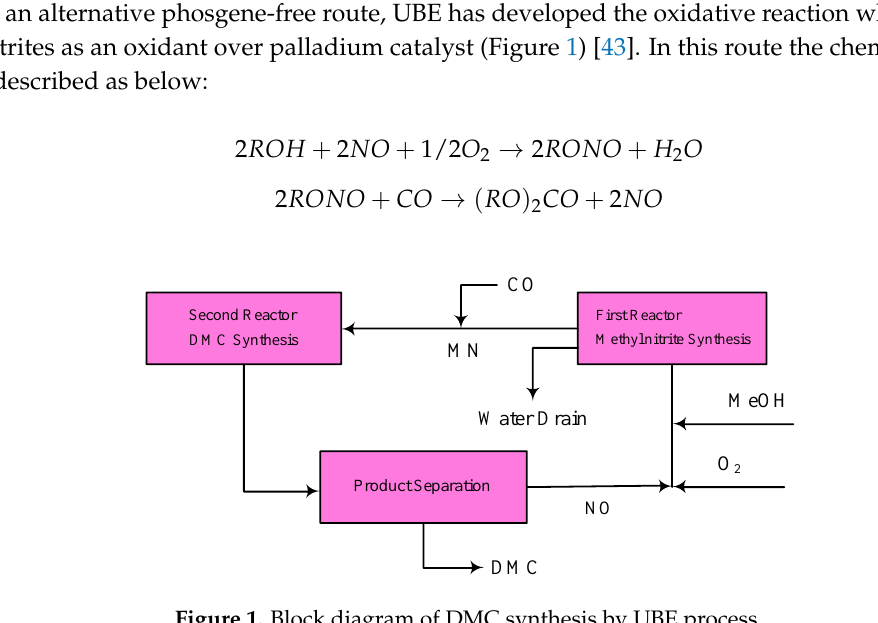
Figure 1. Block diagram of DMC synthesis by UBE process.